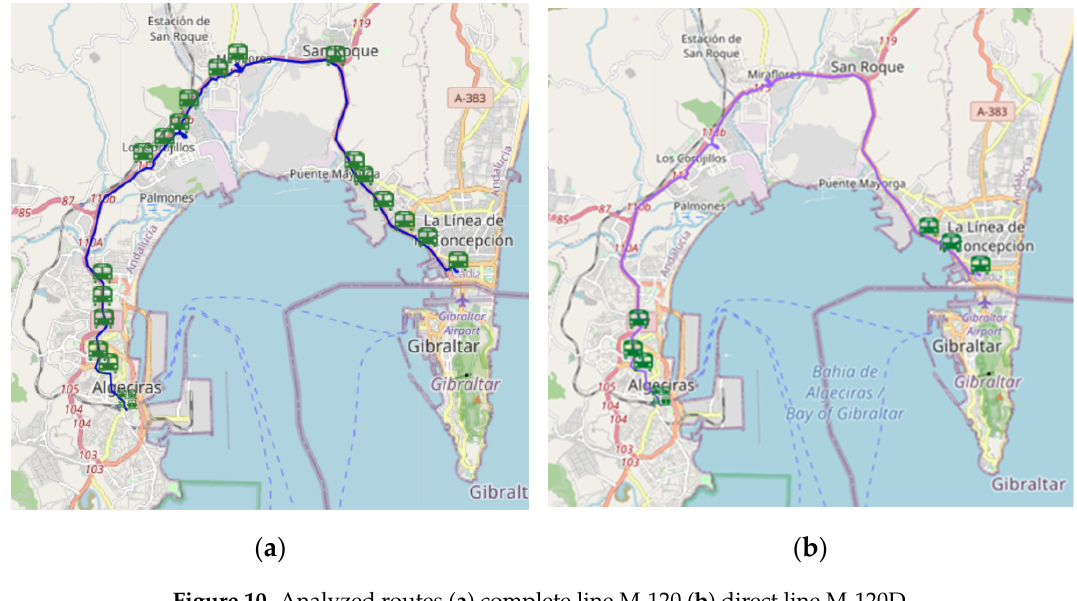
Figure 10. Analyzed routes ( a ) complete line M-120 ( b ) direct line M-120D.